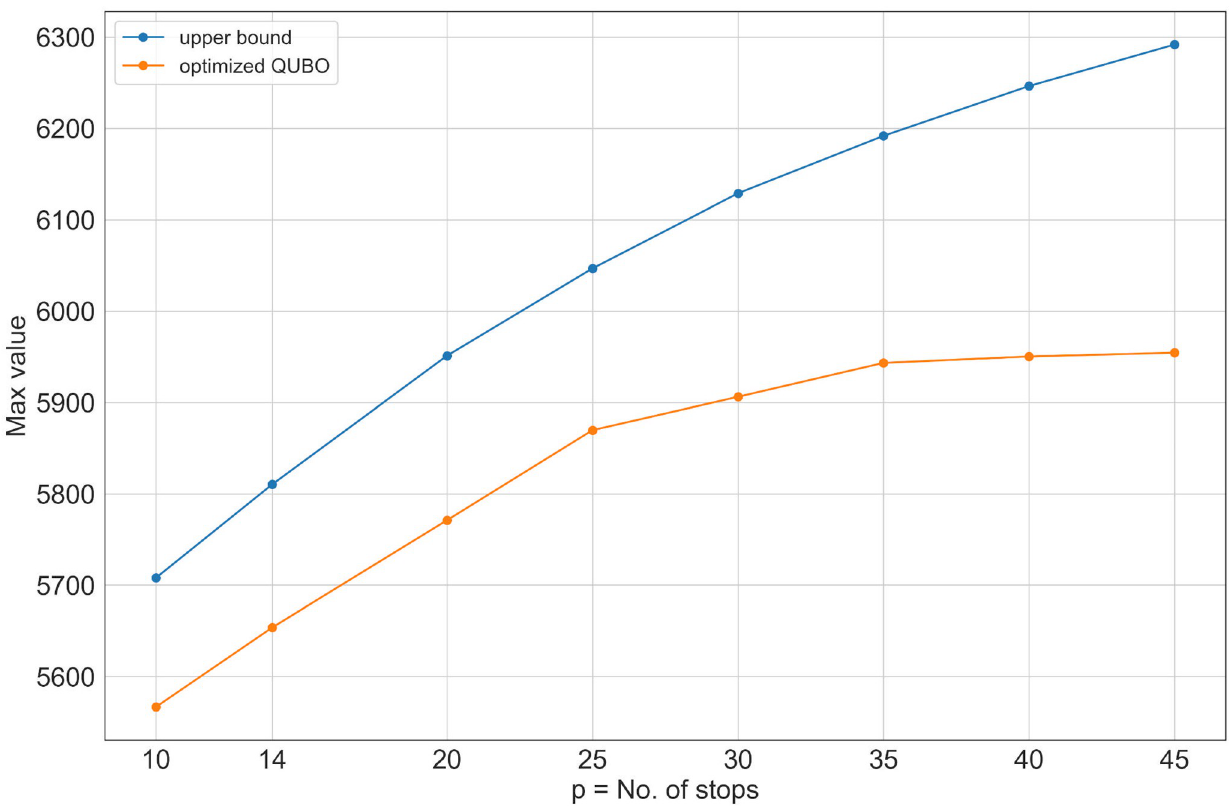
Fig 7. The objective function maximum for p retained stops and corresponding theoretical upper